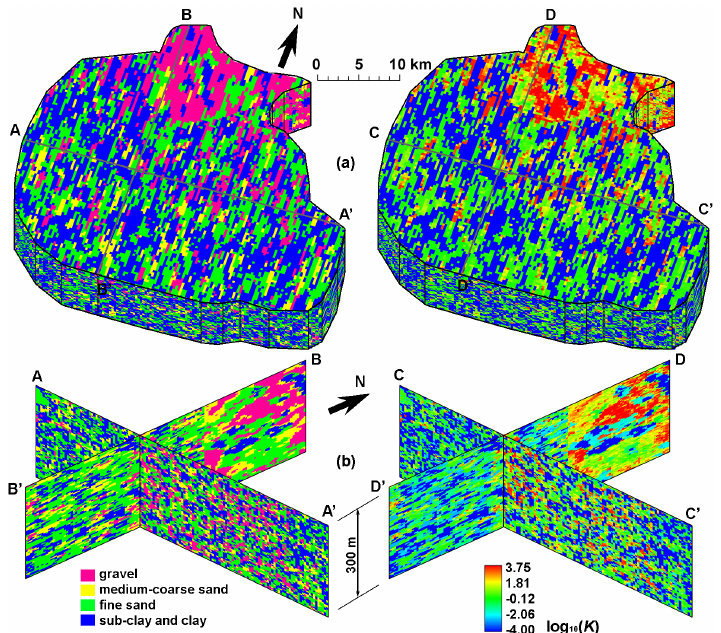
Figure 9. Distribution of hydrofacies (after Zhu et al., 2016a) and log 10 (K) in the three-dimensional (3-D) domain representing the Chaobai alluvial fan: (a) axonometric projection of the 3-D system and (b) vertical sections along the A–A’, B–B’, C–C’ and D–D’ alignments. The vertical exaggeration is 25. The selected cell size is 300m in north–south and east–west directions and 5m in vertical direction, with a total number of 747540 cells. The thickness of the simulated domain is